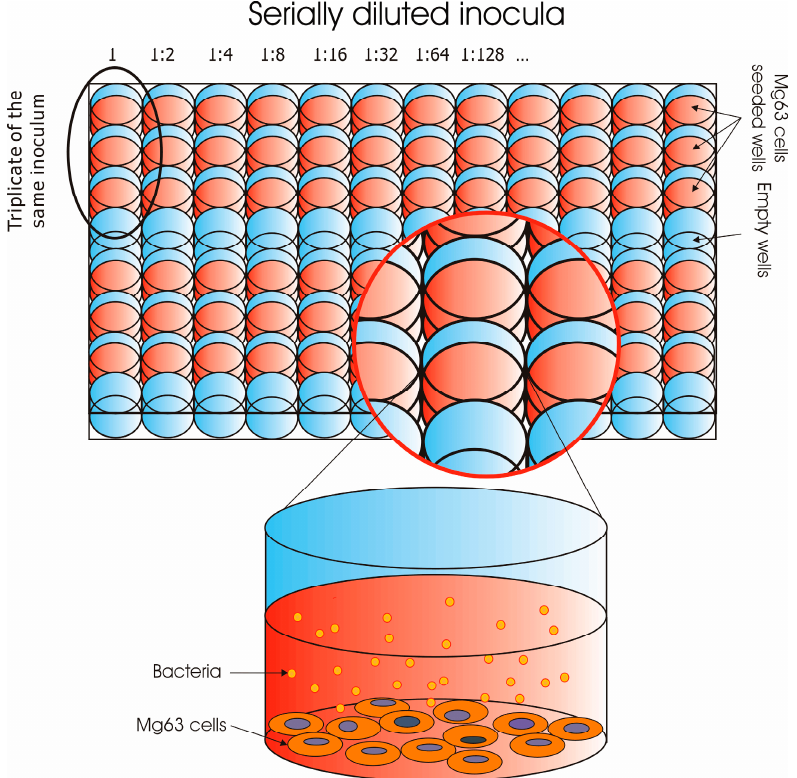
Figure 1. Scheme showing the organisation of the multiwell plates seeded with MG63 cells and subsequently treated with serial dilutions of bacterial suspensions. In the case of species incompetent for internalization, 10 dilutions of the starting bacterial suspensions were sufficient to reach levels with total absence of internalised bacteria and, thus, two bacterial strains could be contemporarily run on the same plate. Conversely, with S. aureus , greater dilutions needed to be reached.